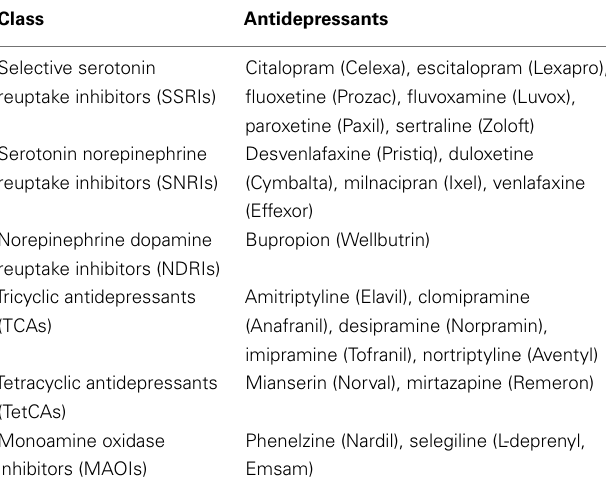
Table 1 | Classes of antidepressant drugs along with their chemical and trade names (in